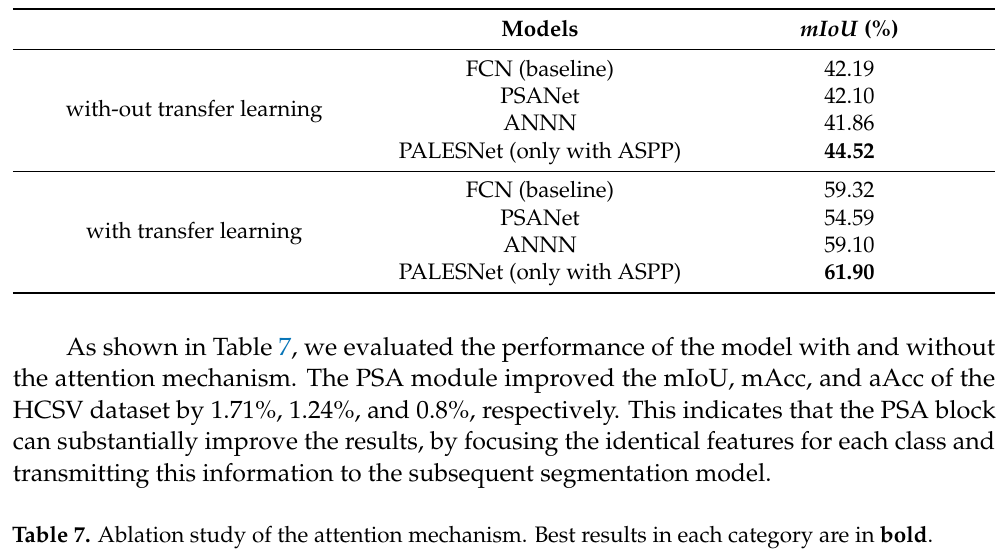
Table 6. Ablation study of transfer learning and the ASPP block. Best results in each category are in bold .